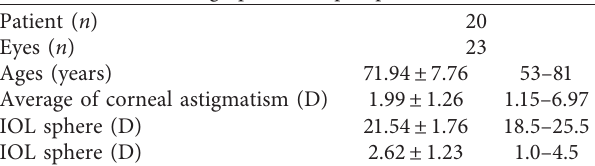
Figure 4: Inclination pattern in the central 3-mm zone. (a, b) show two main meridional lines that are not approximately vertically distributed. The green angle in (a) is obviously not a right angle. Table 1: Patient demographics and preoperative